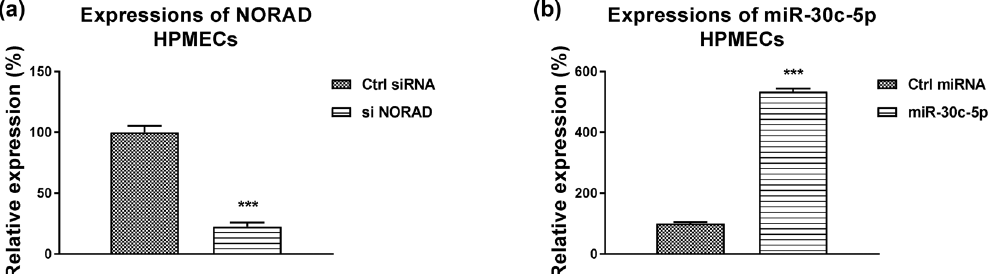
Figure A2: Transfection e ffi ciency of si NORAD and miR - 30c - 5p in HPMECs. ( a ) HPMECs were transfected with control siRNA or si NORAD. Expressions of NORAD were examined by qRT - PCR. ( b ) HPMECs were transfected with control miRNA or miR - 30c - 5p. Expressions of miR - 30c - 5p were examined by qRT - PCR. ***, p < 0.001.